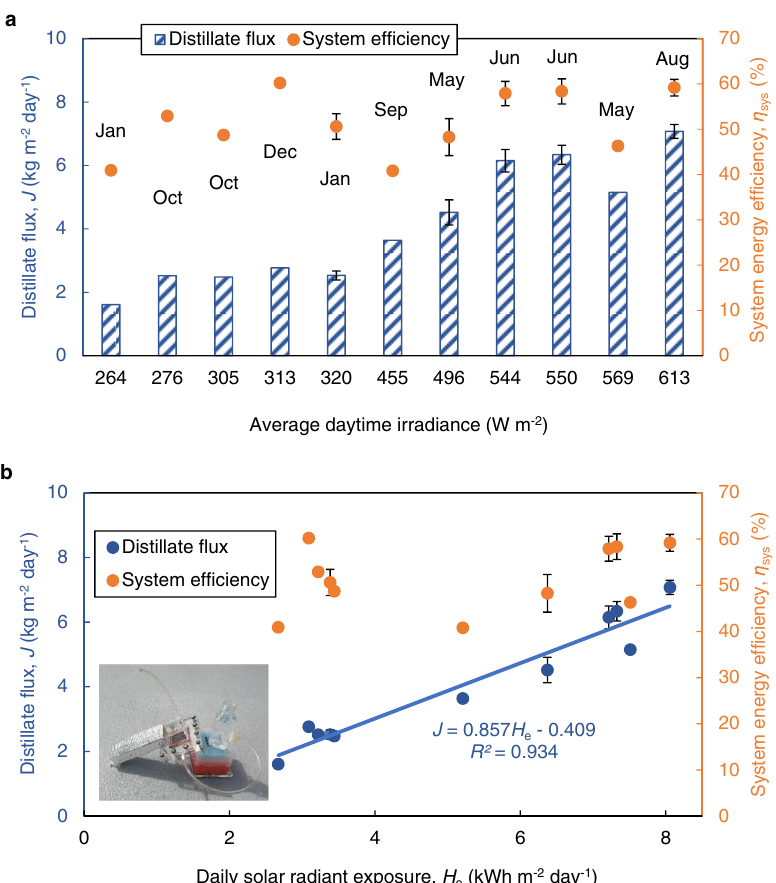
Fig. 1 The performance of single-stage planar systems under natural sunlight. a Distillate production rates per unit area of black membrane (i.e., distillate fl uxes, J ) and the corresponding system energy ef fi ciencies, ƞ sys , of the single-stage planar system (membrane dimensions: 50 mm × 50 mm) under natural sunlight in different months at different average daytime irradiances. b Distillate production fl uxes and the corresponding energy ef fi ciencies with respect to daily solar radiant exposure, H e , for the same experiments presented in a . The inset of Fig. 1b is the photograph of a single-stage planar system. The systems were placed at an inclination of 30° with respect to the horizontal, facing south under natural sunlight from sunrise to sunset during experiments. The surface density of carbon black NPs on the permeate side of PVDF membranes (pore size: 0.45 µm) was 7.5 ‒ 7.9 g m − 2 and the hydrostatic pressure at the center of the membrane was 95 ‒ 105 mmH 2 O (i.e., 0.93 ‒ 1.03 kPa), as shown in Supplementary Table 2. DI water was used as feedwater in these experiments, during which the temperature of feedwater was within 16 ‒ 38 °C. Variation in irradiance and weather condition can be found in Supplementary Table 1. The error bars represent the standard deviations of duplicate results obtained using two different systems on the same